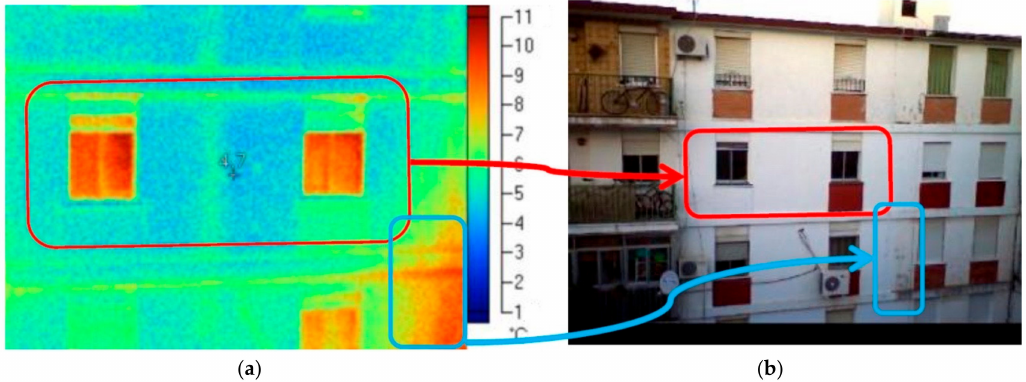
Figure 7. ( a ) Thermal behavior of the dwelling exterior façade; ( b ) Visual aspect.